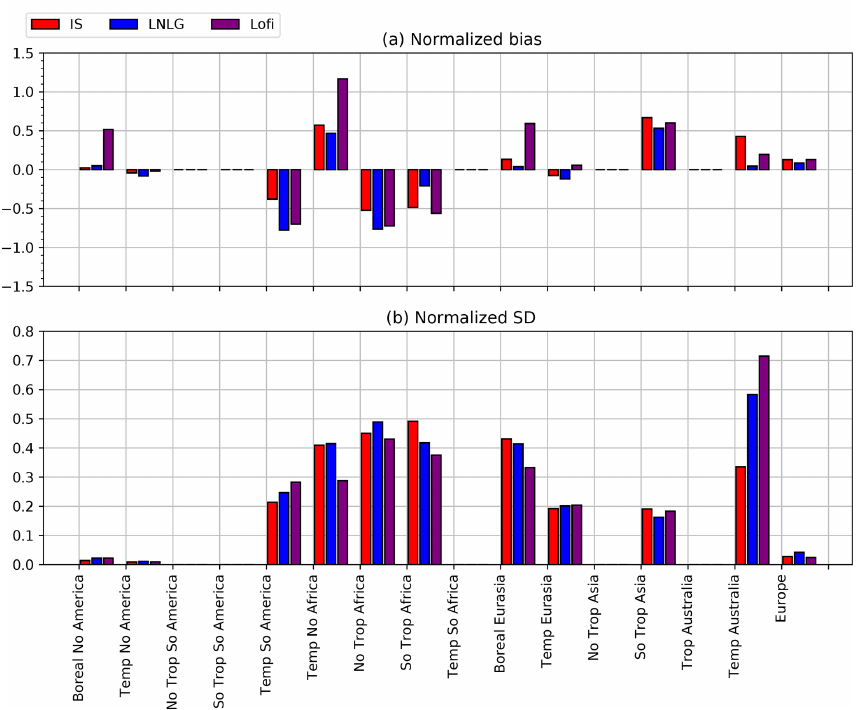
Figure 13. Same as Fig. 12, but instead of an evaluation by latitude, the evaluation is by MIP region. No: northern; So: southern.